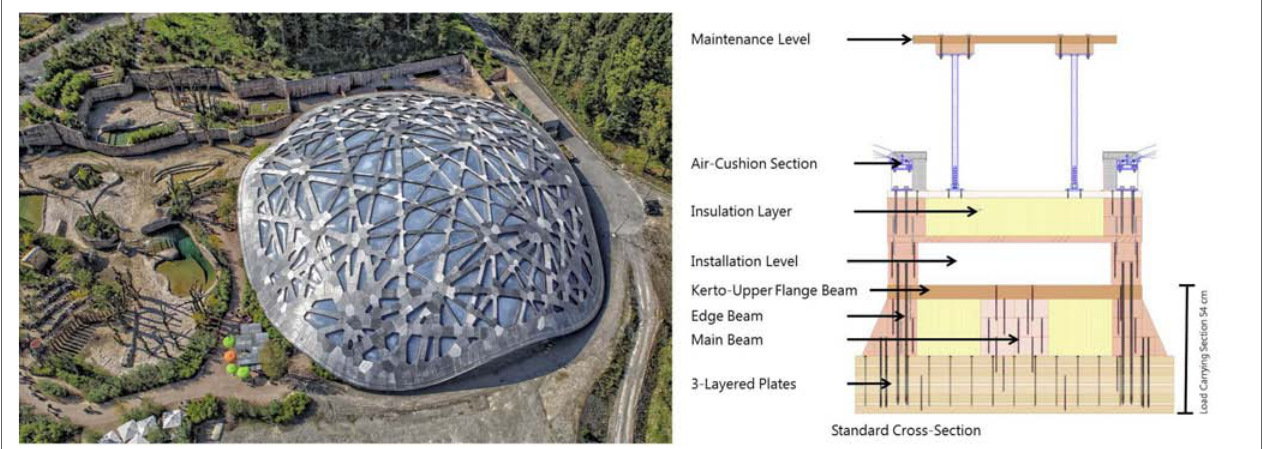
FIGURE 1 | Left: aerial view of the structure (Gomez, 2015); right: cross-section of the timber roof .